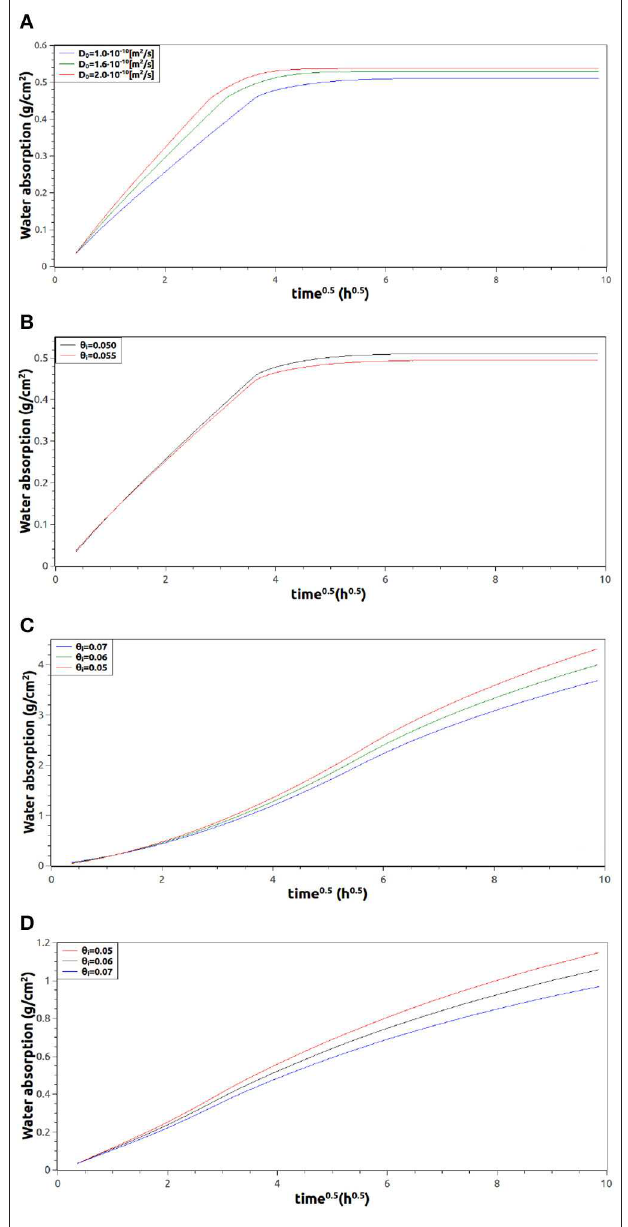
FIGURE 4 | Numerical water absorption profiles, divided by the exposed area to free water, as a function of time in different geometrical configurations. (A,B) Profiles of case (a) in Figure 2 varying D 0 and θ i , respectively. (C,D) Profiles of water absorption varying θ i corresponding to cases (b and c) in Figure 2 ,